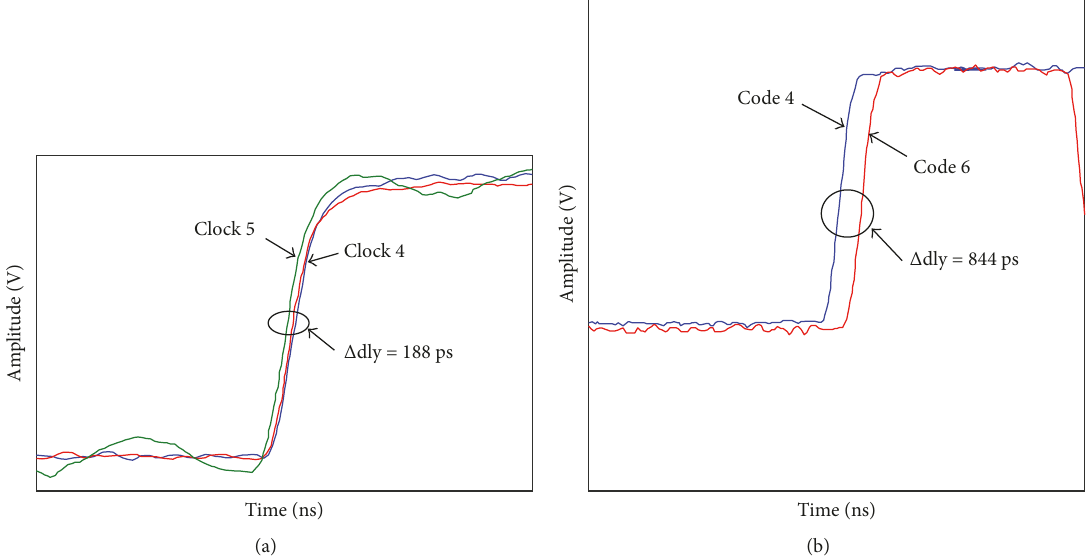
Figure 5: Generated signals by the FPGA measured using oscilloscope. (a) Generated clock signals (Clock 4 and Clock 5) and (b) Generated codes (C4 and